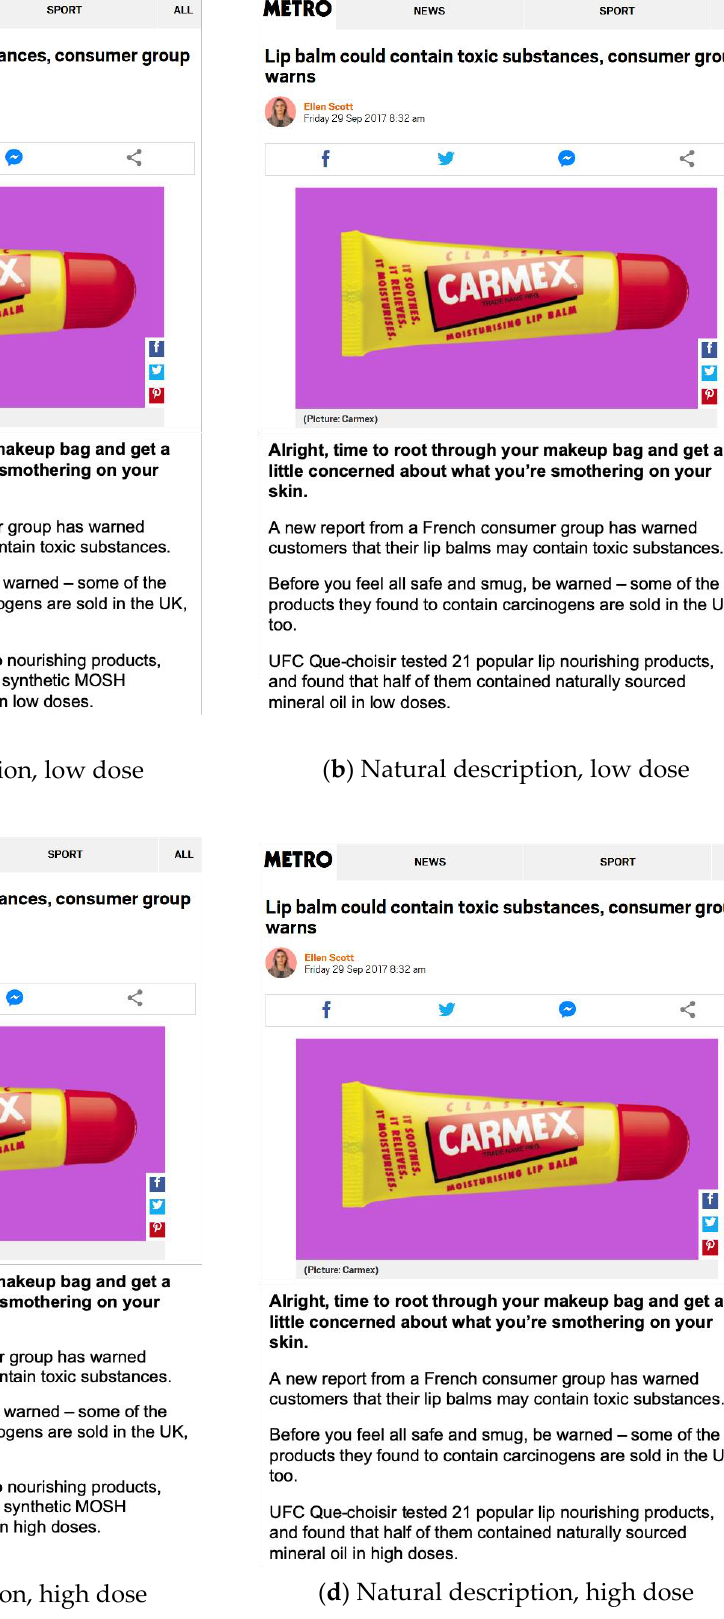
Figure 2. Stimuli. Each participant randomly received one of the four stimuli, presented as news report warning about a toxic substance in lip balm either described as “naturally sourced mineral oil” or “synthetic MOSH (mineral oil saturated hydrocarbons)” and present in “high” or “low” dose.